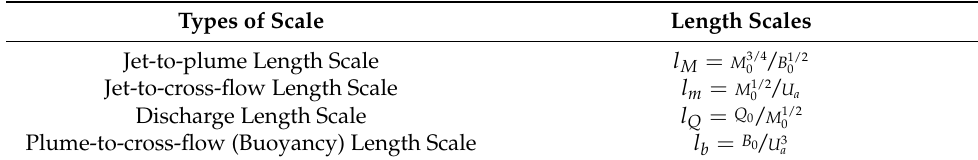
Table 2. Introduction of the dynamic length scales of jets.